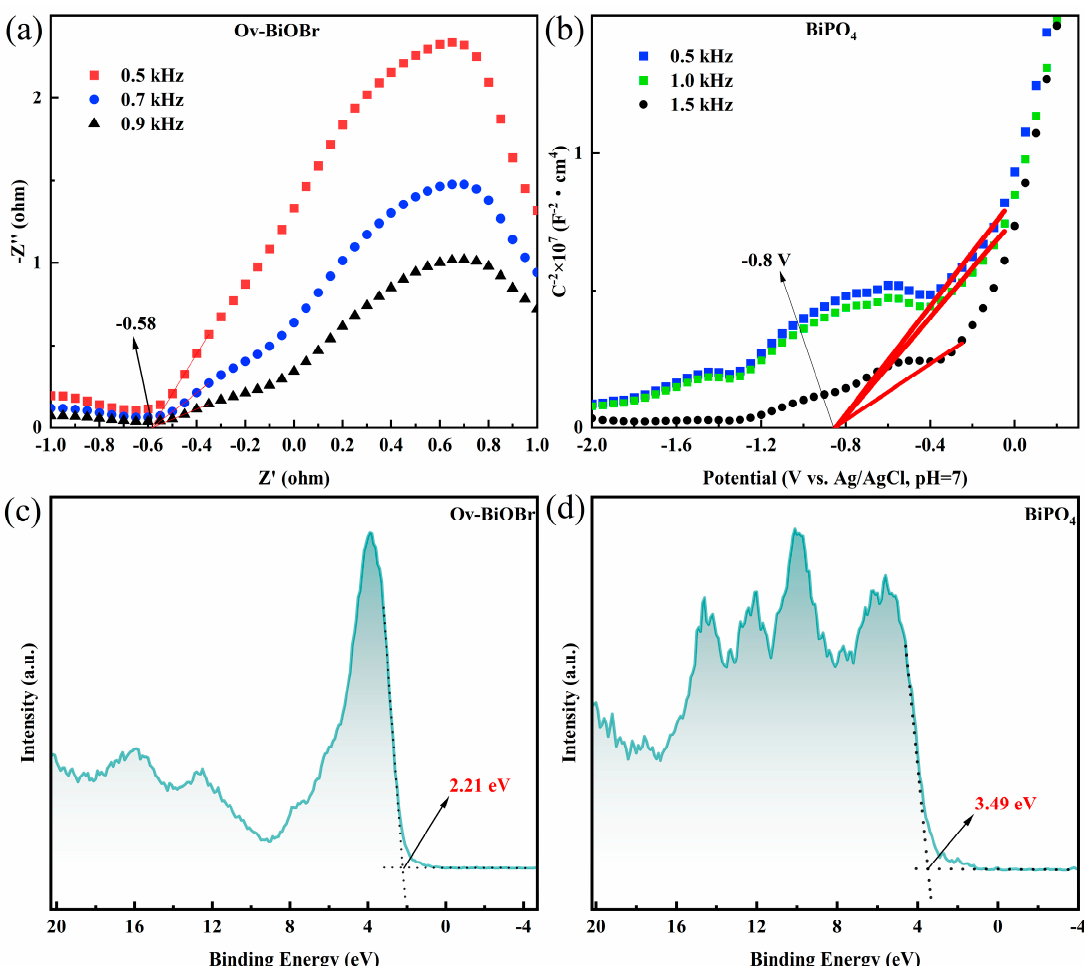
Figure 6. M-S plots ( a , b ) and VB-XPS ( c , d ) of Ov-BiOBr, BiPO 4.